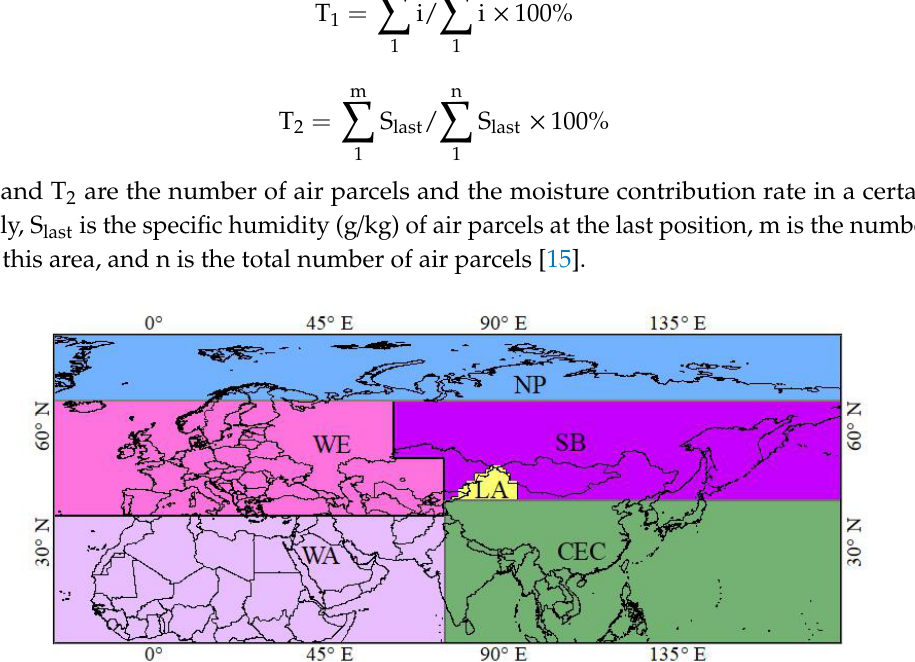
precipitation in the study area, and time was defined based on the HYSPLIT model simulation. The HYSPLIT initial simulation height is 1500 m above the surface in the vertical direction, and the